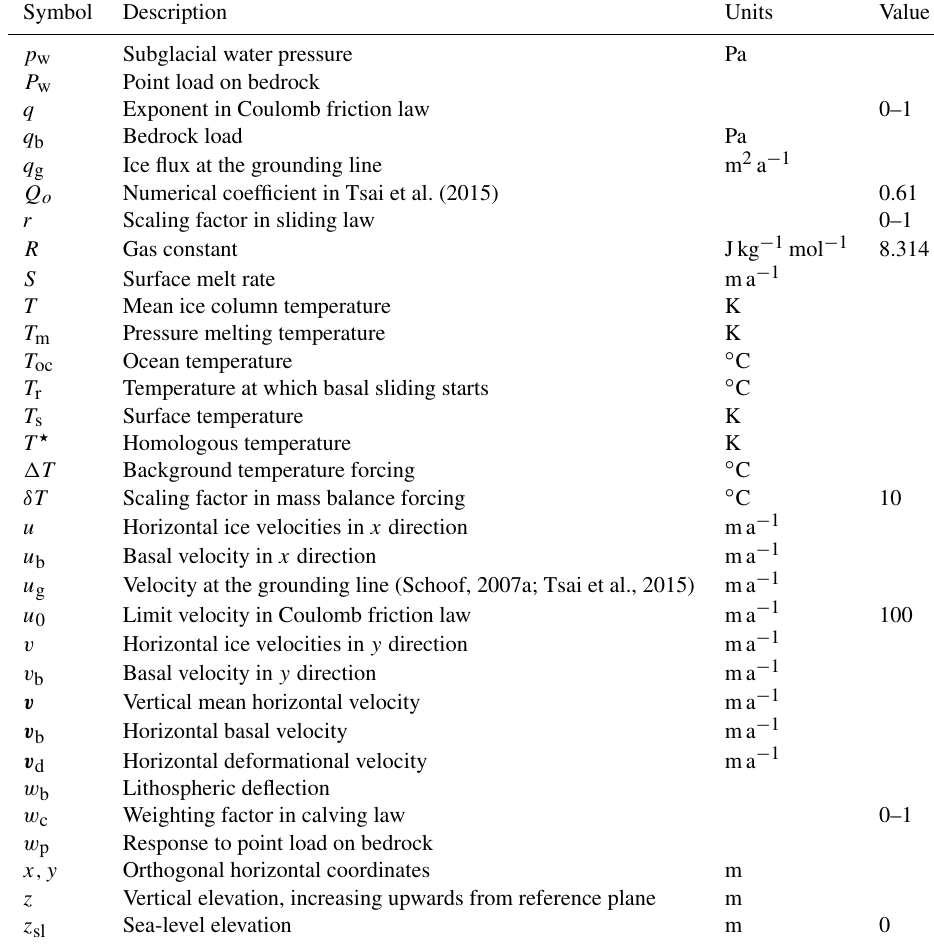
Table 2. Model symbols, units and nominal values (continued).